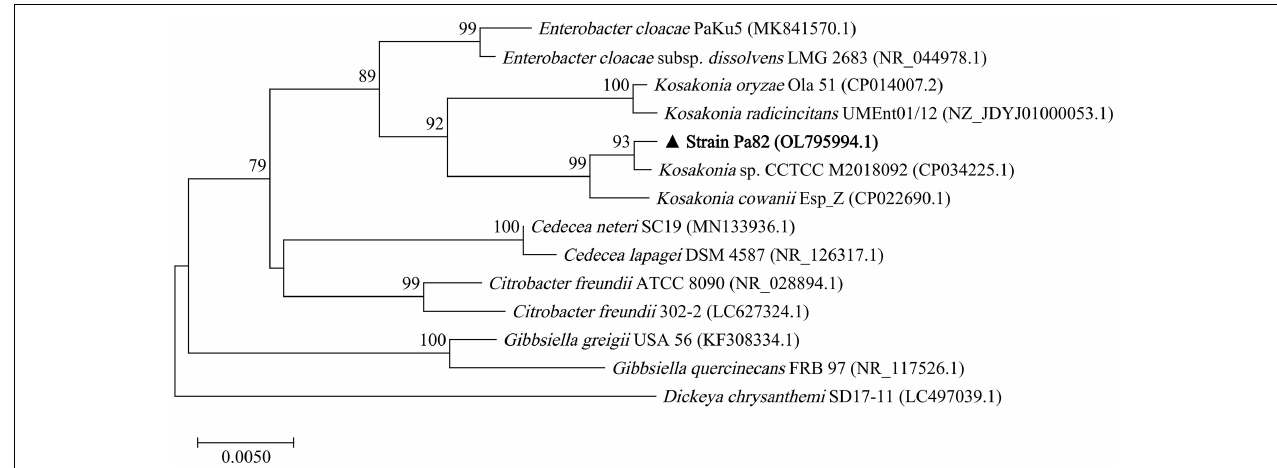
FIGURE 3 | Phylogenetic tree based on 16S rRNA gene sequences from strain Pa82 and its relative strains of family Enterobacteriaceae . The 16S rRNA gene sequence from Dickeya chrysanthemi SD17-11 was used as the outgroup.